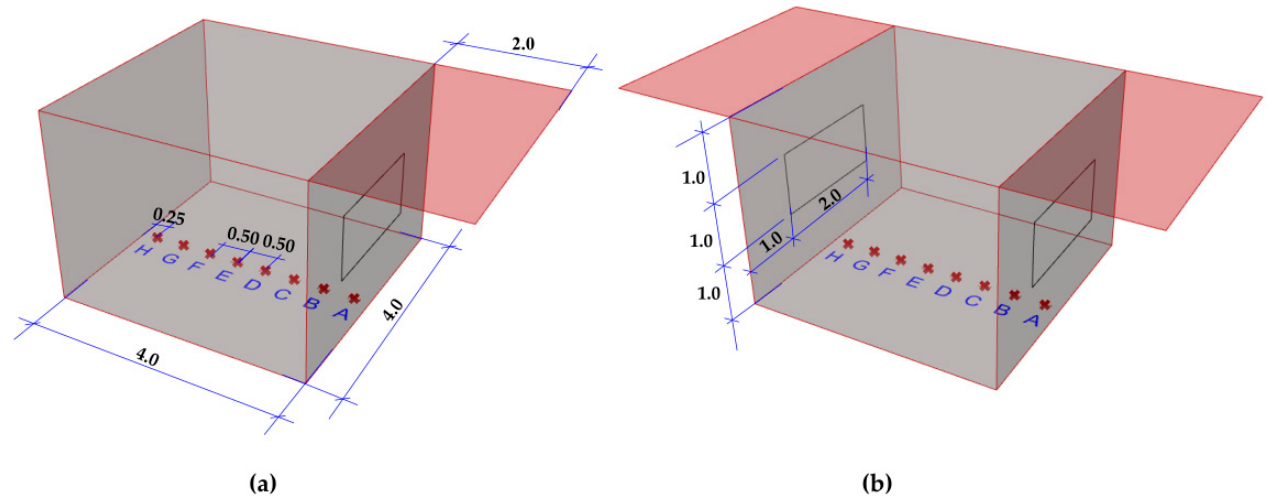
Figure 1. ( a ) CIE test case 5.13 and ( b ) modified CIE Test case 5.13 with bilateral opening.